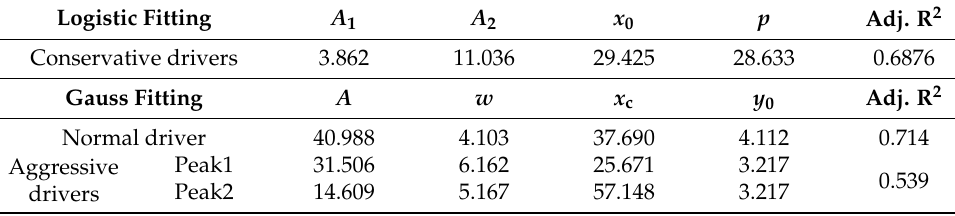
Table 5. The coefficients of curve